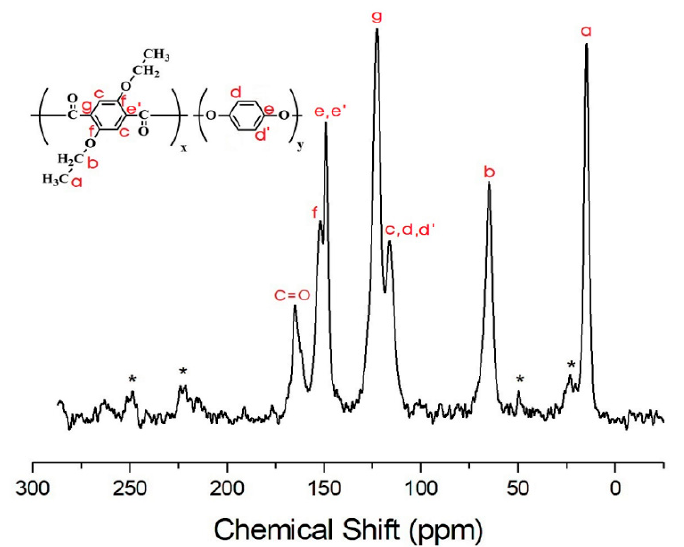
Figure 9. 13 C-NMR chemical shifts of sample I-A at room temperature. In the chemical formula, x:y = 1:1. The spinning sidebands are marked with asterisks.